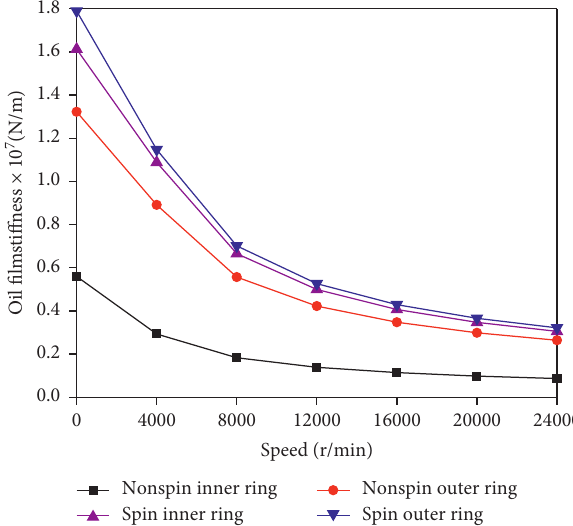
Figure 16: Effects of the speed and spin on film